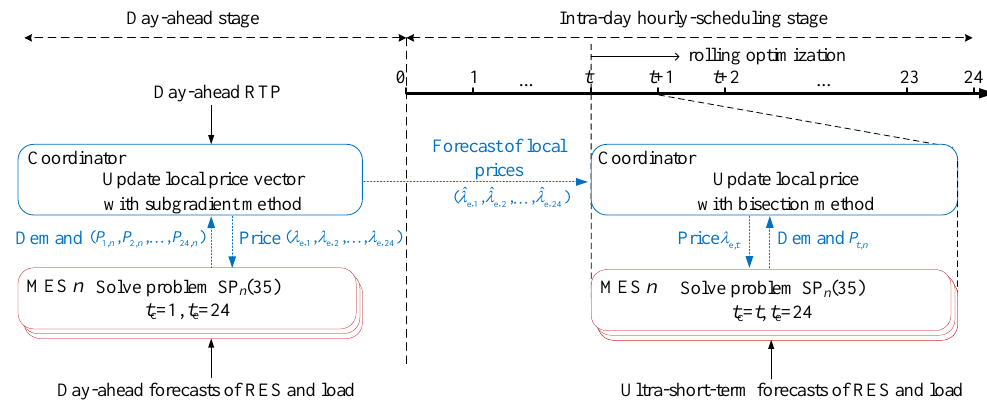
Figure 3. Operation framework diagram for a two-stage TC